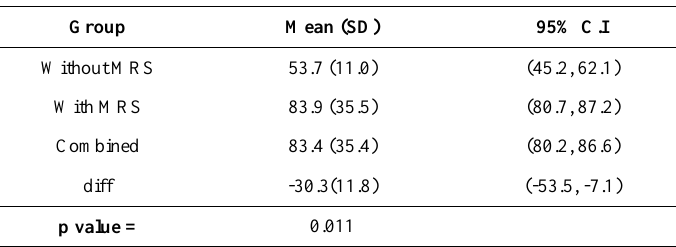
Table 6. Showing mean differences of indoor PM2.5 between participants with and those without respiratory symptoms in rural area